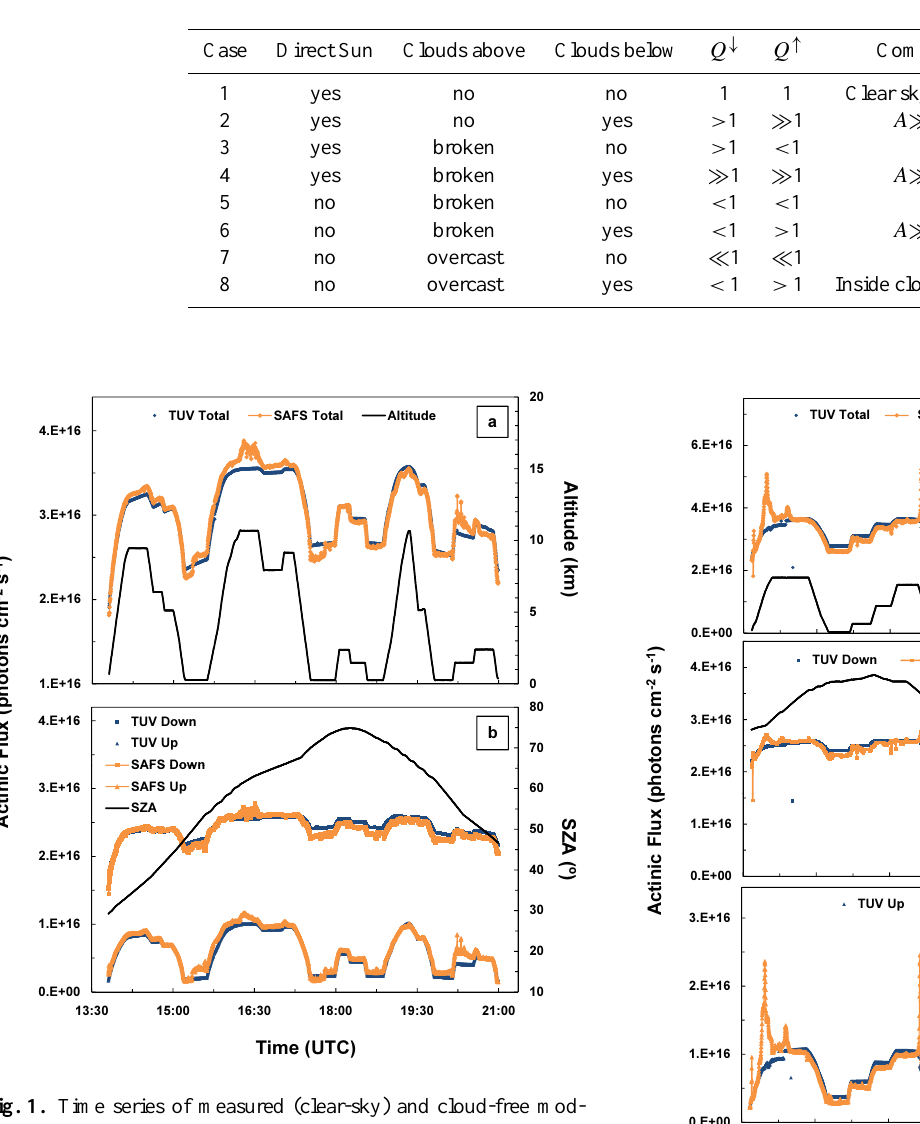
Table 2. Typical sky conditions as seen from an aircraft.